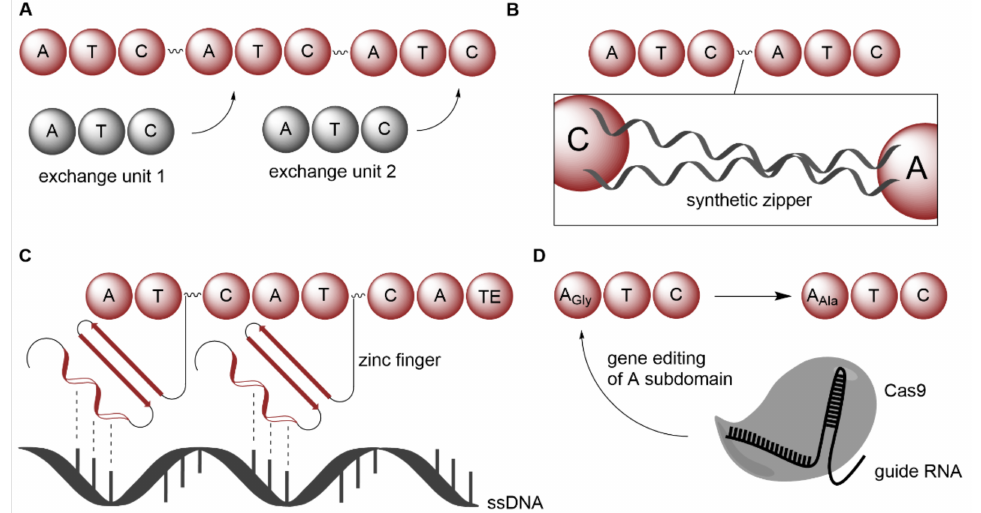
Figure 10. Recently described strategies for the engineering of NRPS. ( A ) Construction of chimeric NRPS from exchange units (XUs). ( B ) Linkage of mono-modular NRPS with synthetic zippers (SZs). ( C ) Generation of DNA-templated NRPS with zinc fingers. ( D ) Swapping of flavodoxin-like subdomains inside A domains with the help of